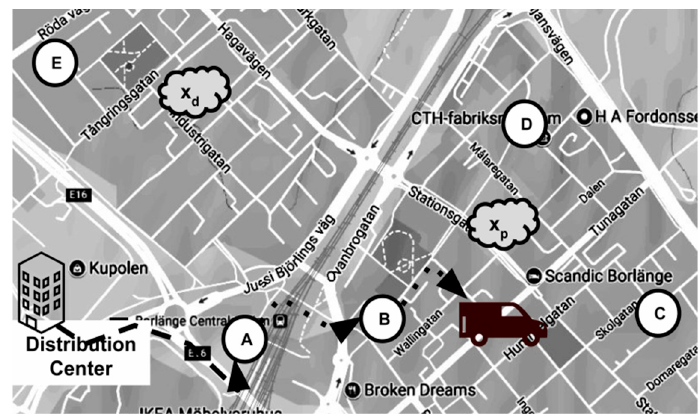
Figure 3. Vehicle routing of deliveries and pick-ups.